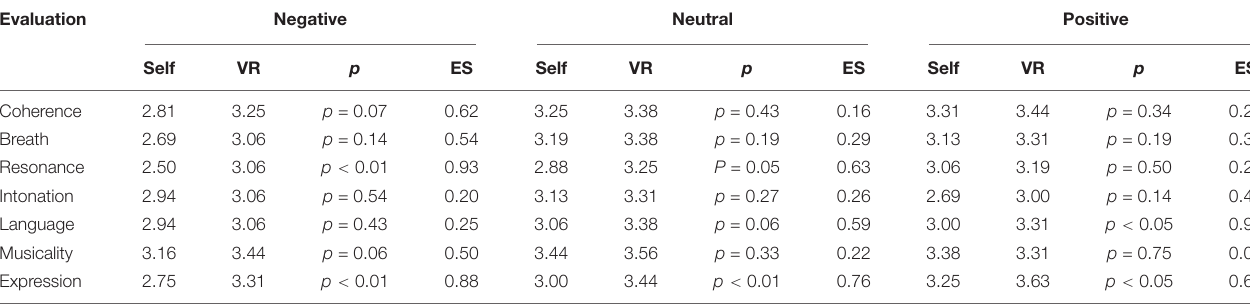
TABLE 3 | Average scores and statistical test results of the self-rating.